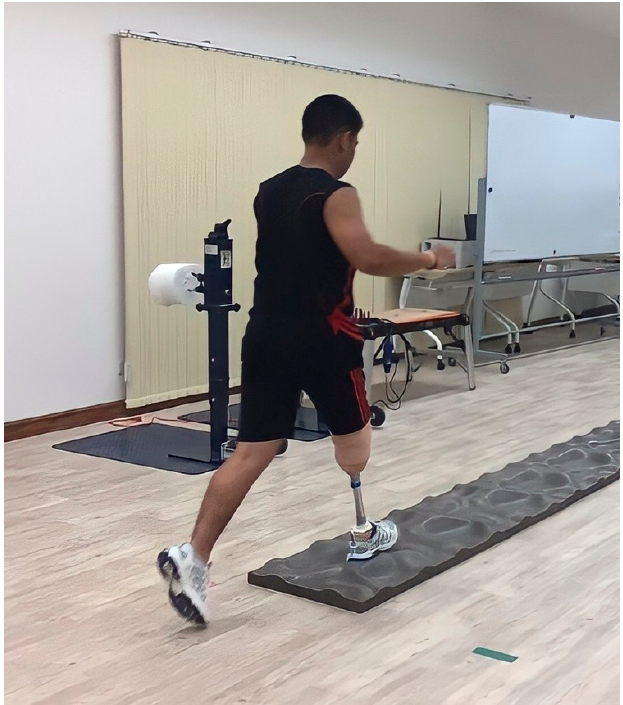
Figure 2. Participant performing uneven terrain outcome measurement .